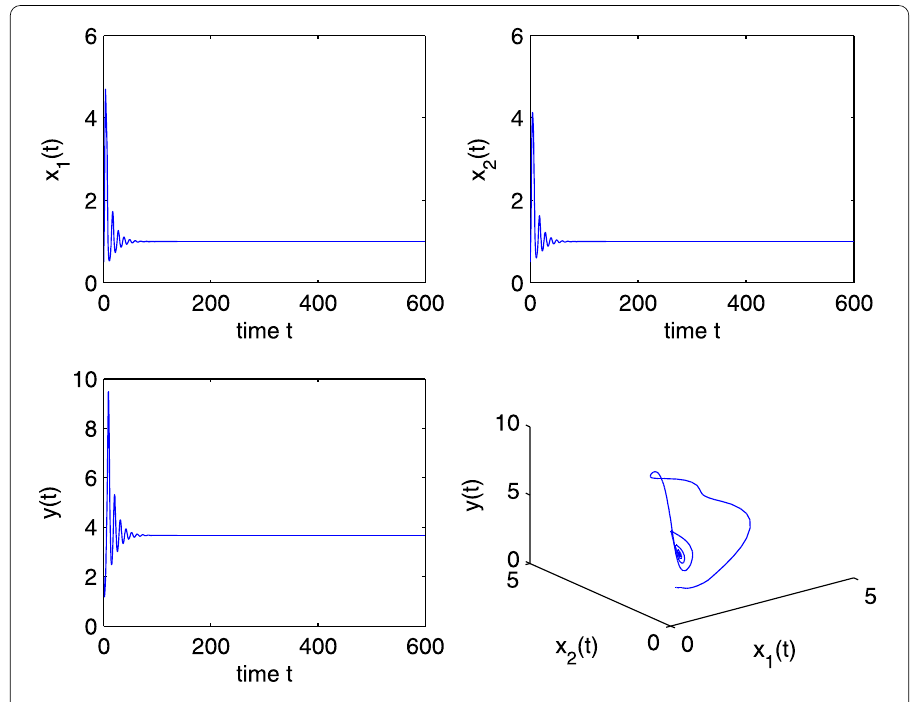
Figure 3 When τ 1 = τ 2 = τ , E ∗ is asymptotically stable for τ = 1.1 < τ 0 = 1.7889